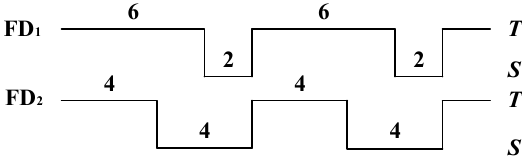
Figure 2. Query accuracy probability and mistake rate.